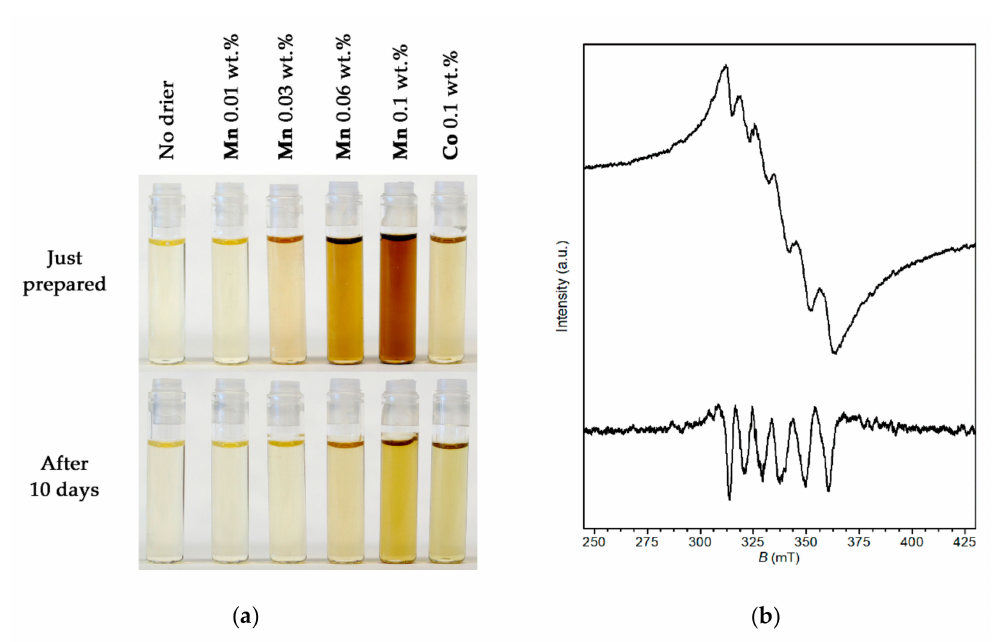
Figure 1. ( a ) Coloration of Mn / S471 formulations and a comparison with samples of neat S471 and Co / S471 (0.1 wt.%); ( b ) Electron Paramagnetic Resonance (EPR) spectrum of Mn / S471 formulation (0.1 wt.%; top) and its derivation (bottom) measured after 10 days of in closed vial ( ν = 9.4274 GHz, | A | = 93.4 × 10 − 4 T, g = iso iso